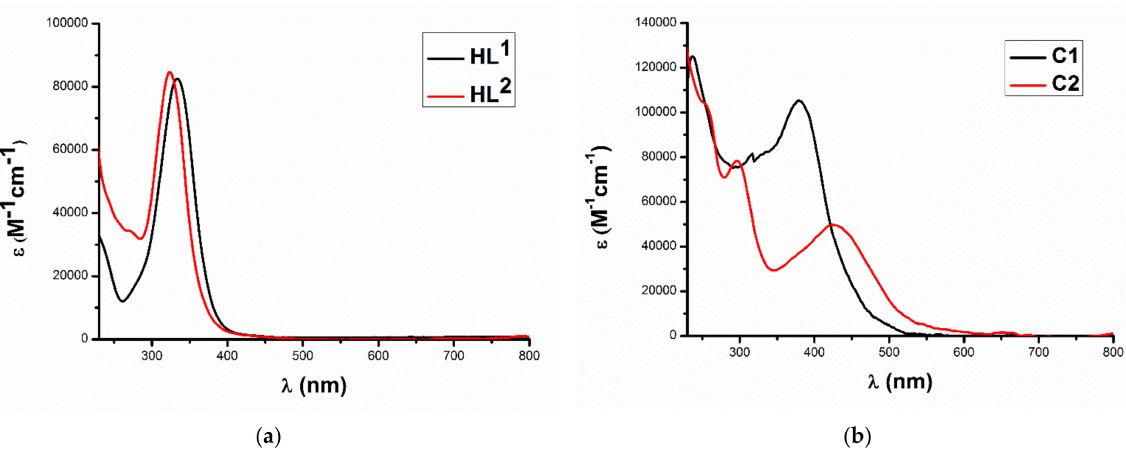
Figure 6. UV-Visible spectra of compounds { HL 1 and HL 2 } ( a ) and compounds { C1 and C2 } ( b ) measured in